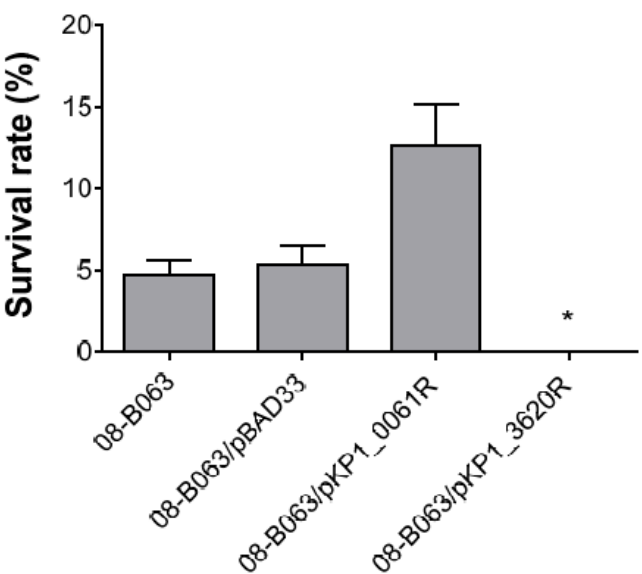
Figure 2. Colistin susceptibility testing in the 08-B063 strain carrying the pKP1_0061R or pKP1_3620R vector. The strains were challenged with 1 mg/L of colistin for 1 h. * After 1 h incubation with colistin, survival of 08-B063/pKP1_3620R could not be detected due to values less than a detection limit of 50 CFU/mL. Table 3. Colistin MICs in 08-B063 strain harboring a pBAD33 vector containing altered genes. Isolates